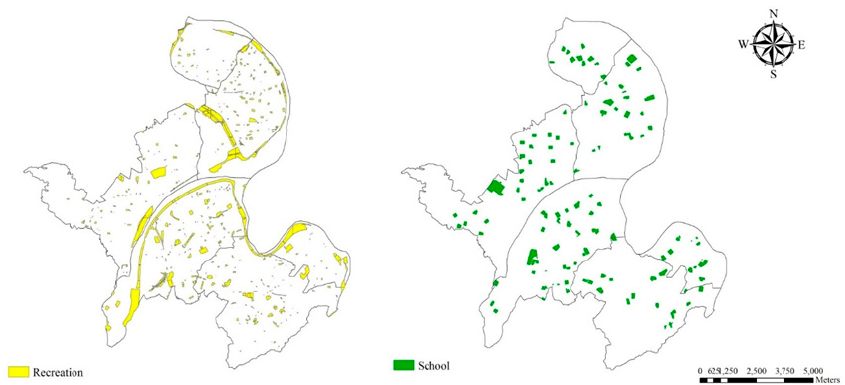
Figure 2. Locations of open spaces in the metropolitan area (six districts) of New Taipei City.